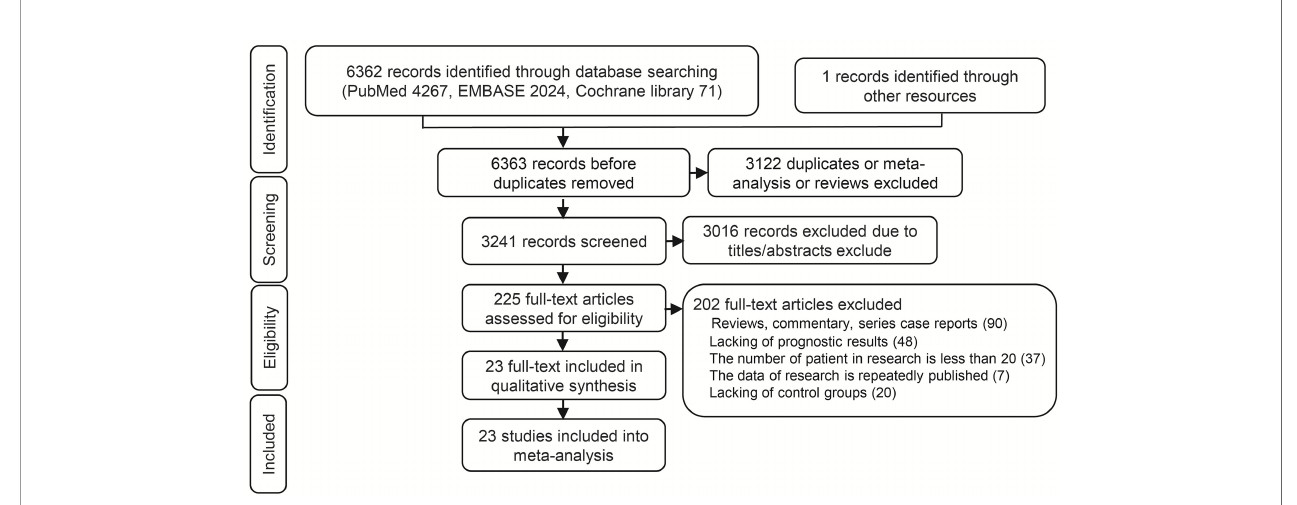
FIGURE 1 | Flow chart of the identi fi cation process for eligible